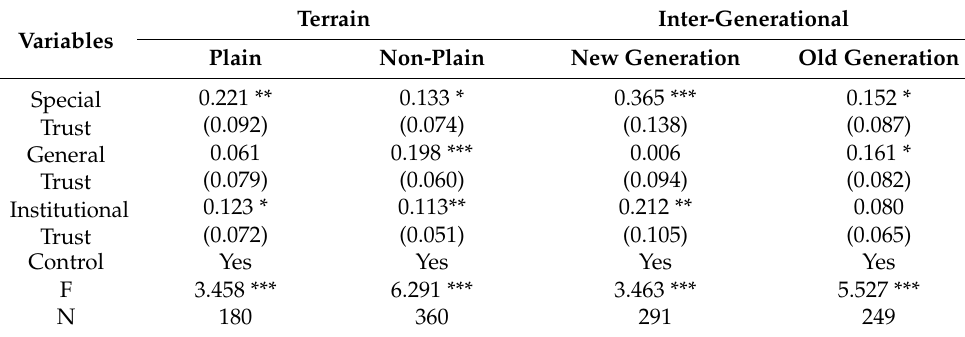
Table 5. Heterogeneity analysis regression